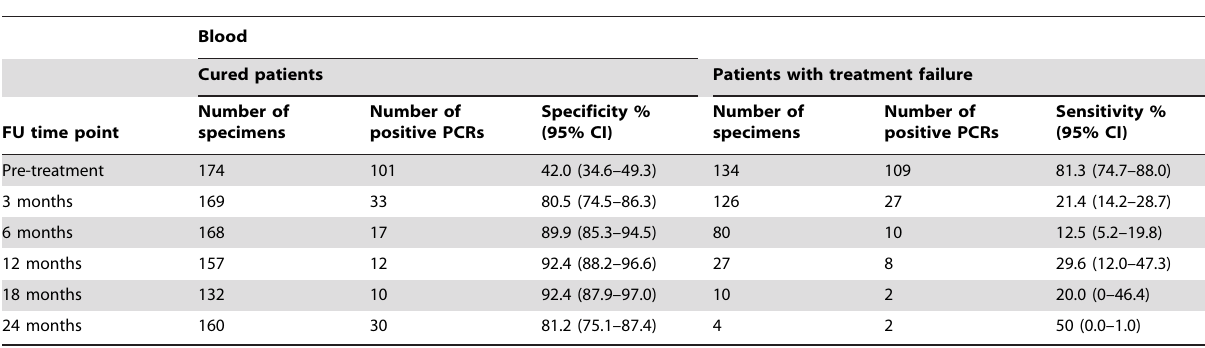
Table 3. Specificity and sensitivity of PCR on blood during post-treatment follow-up.